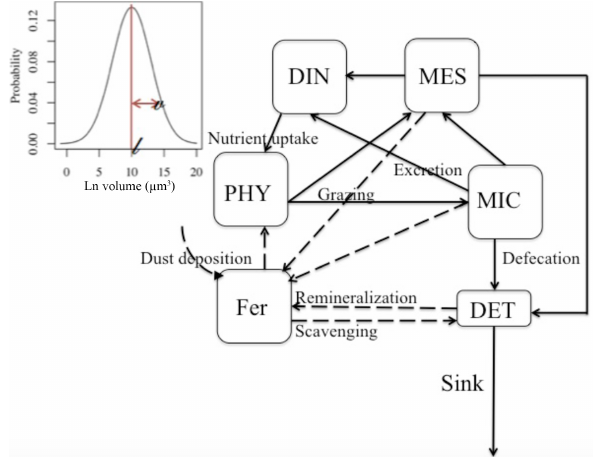
Figure 1. Schematic description of the CITRATE model. Thick ar- rows indicate nitrogen flows and dashed lines indicate the simplified iron cycle. The inset denotes an example of a phytoplankton com- munity with a lognormal distribution for cell